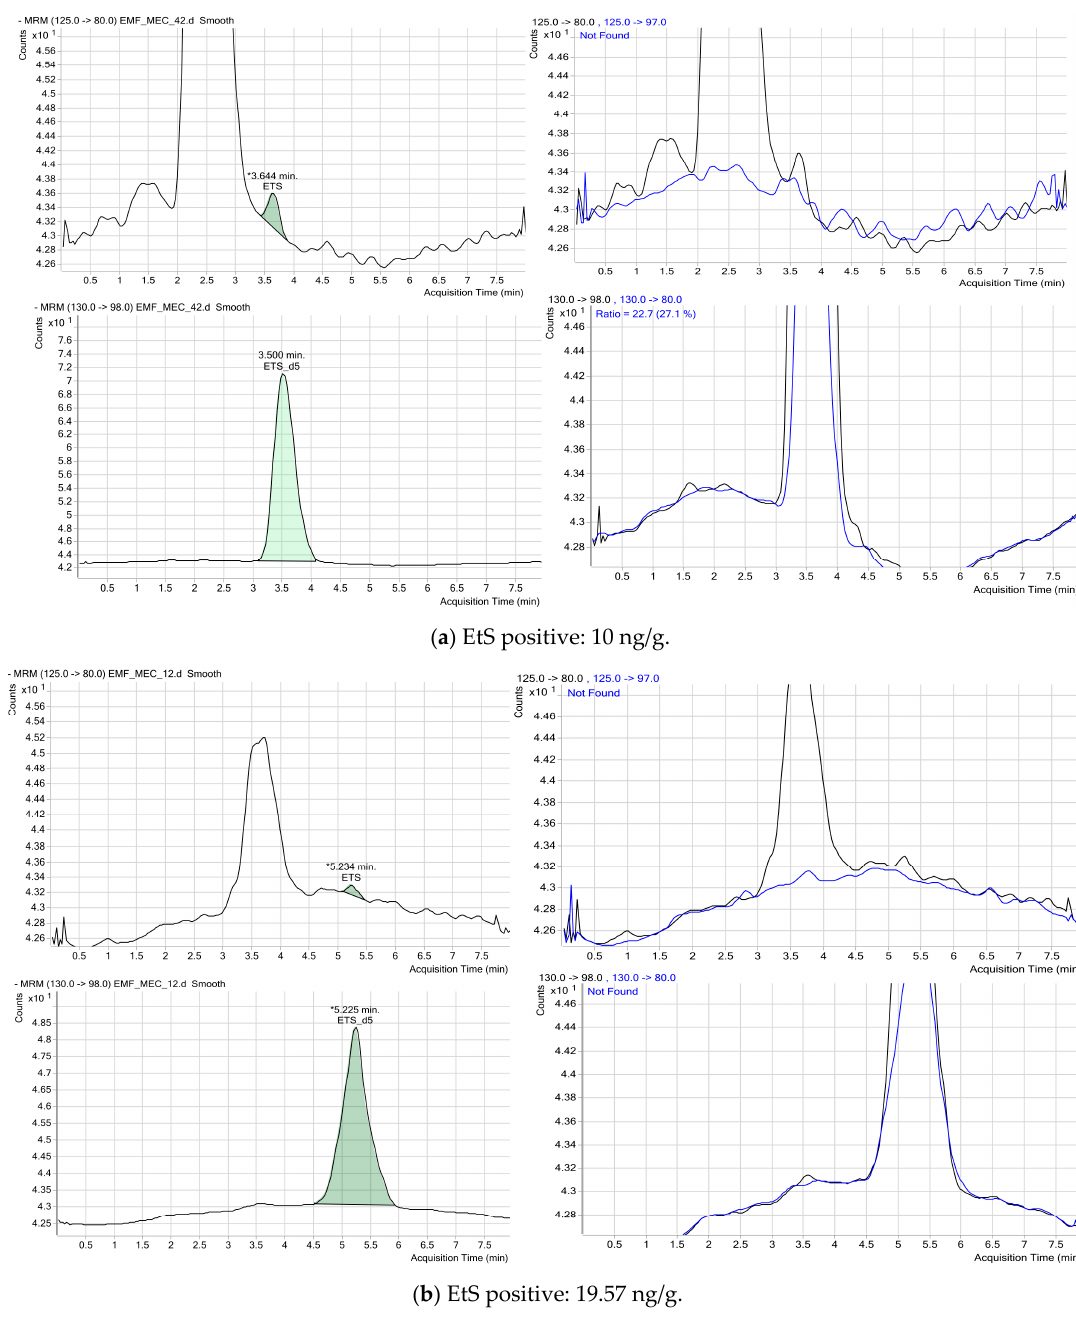
Figure 3. Chromatogram in two meconium samples testing positive for EtS. The retention time of substance ranged from 4.5 to 5.5 min depending on the column life span. The black line depicts the quantitative transitions and the blue line depicts the qualitative transitions. The green shade represents the quantification of EtS using the calibration curves. The “multiple reaction monitoring” (MRM) program takes into account the following transitions: EtS quantifier 125 > 80 and qualifier 125 > 97, and internal standard (EtS-d5) quantifier 130 > 98 and qualifier 130 > 80. ( a ) sample EMF_MEC_42 with a positive concentration of 10 ng/g; ( b ) sample EMF_MEC_12 with a positive concentration of 19.57 ng/g.